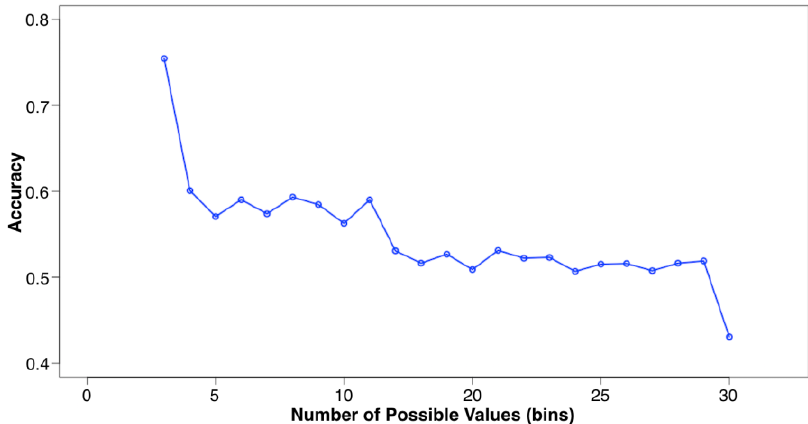
Figure 8. Correlation between accuracy and number of possible values.